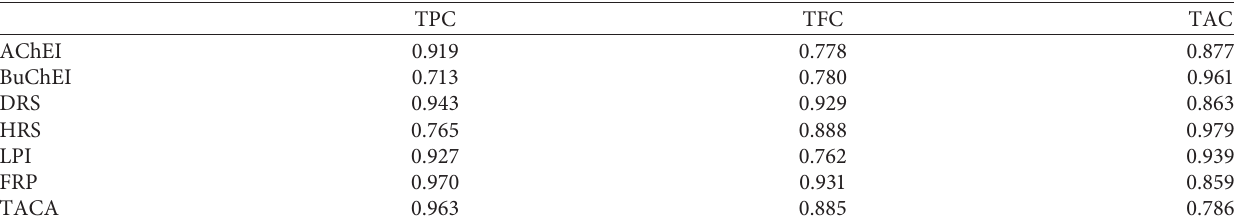
Table 2: Pearson correlation coefficients of total phenolic, flavonoid, and alkaloid contents with cholinesterase inhibitory and antioxidant